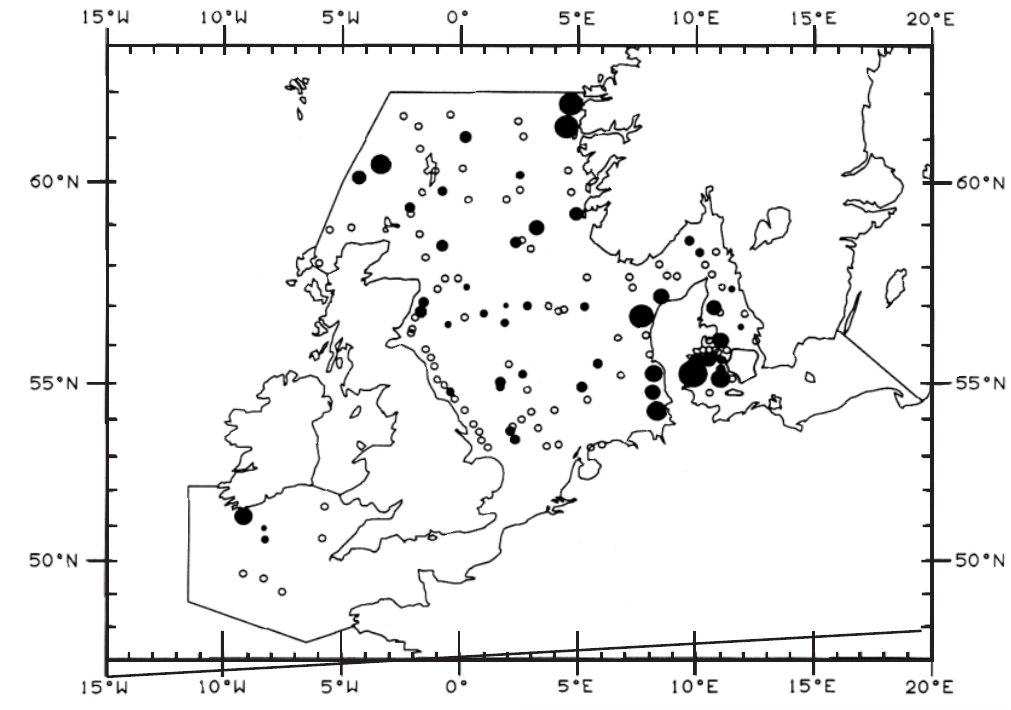
Fig. 3. Distribution of porpoise calf sightings during July 1994 (after Hammond et al. 1995), showing ratio of calf sightings to all porpoise sightings for each leg of survey effort. The black dot size is proportional to the calf ratio. Open dots indicate zero